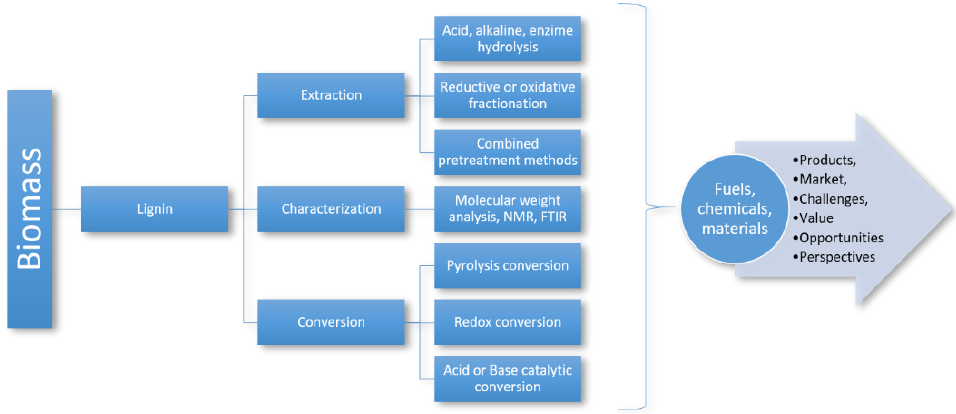
Figure 7. Overview of valorization of lignin to valuable products [39].